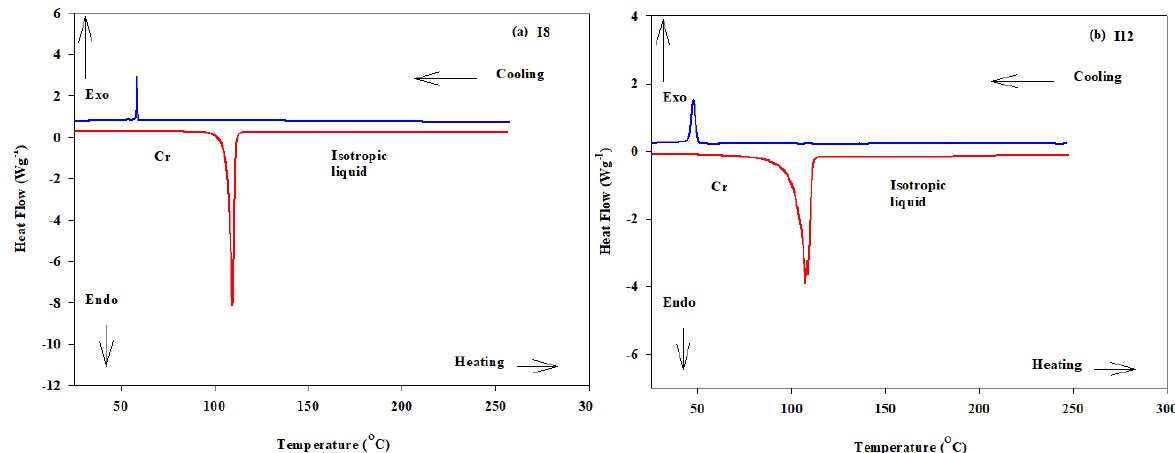
Figure 3. Thermograms driven from DSC for ( a ) sample I8 and ( b ) sample I12 at heating rate of 10 °C min − 1 . Table 1. Transition temperatures ( ◦ C) and their enthalpies ∆ H , kJmol − 1 , for compound, In . Upon Heating Upon Cooling Comp. T Cr-I